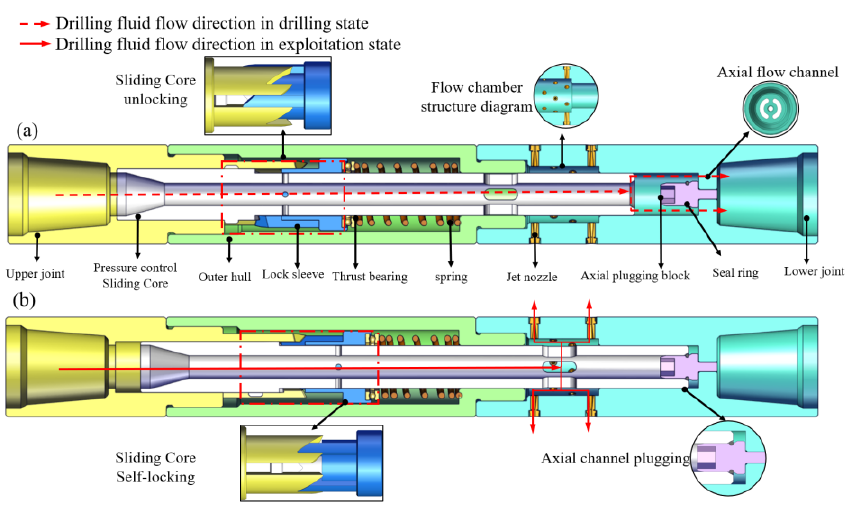
Figure 2. Structure diagram of PJCT: ( a ) PJCT in closed state, ( b ) PJCT in opend state.